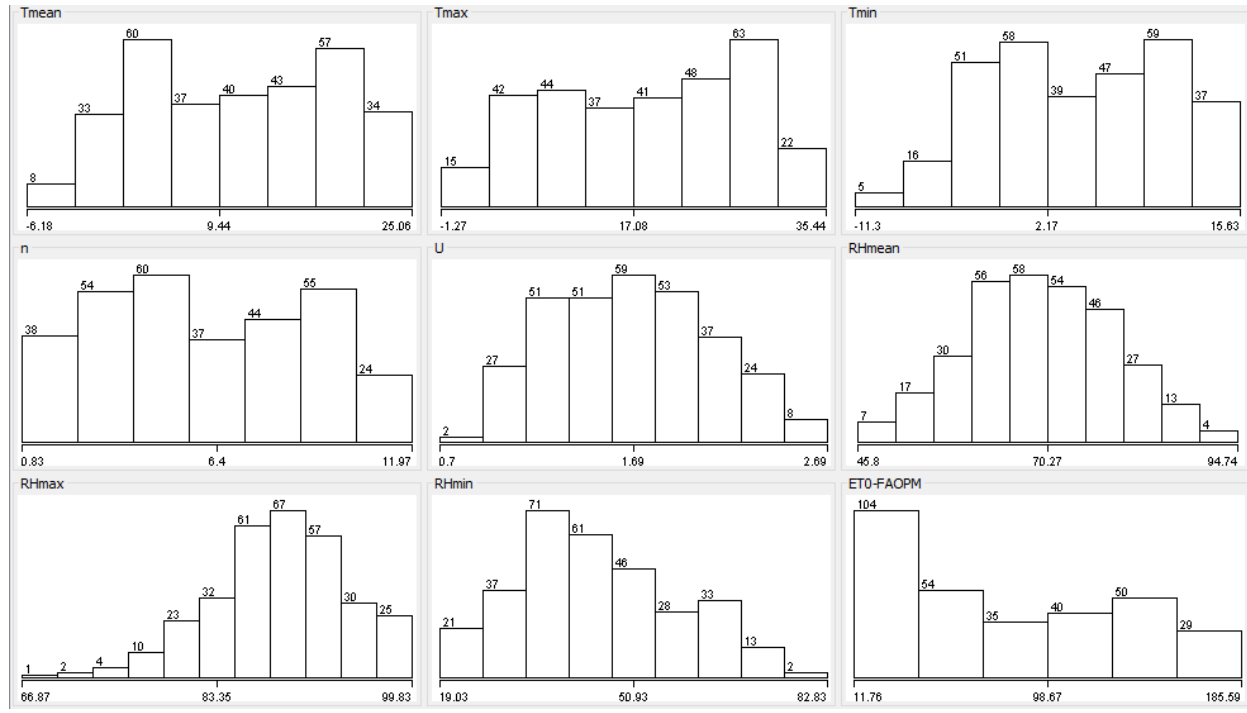
Figure 2. Frequency distributions of meteorological input dataset conforming to the distribution statistics.